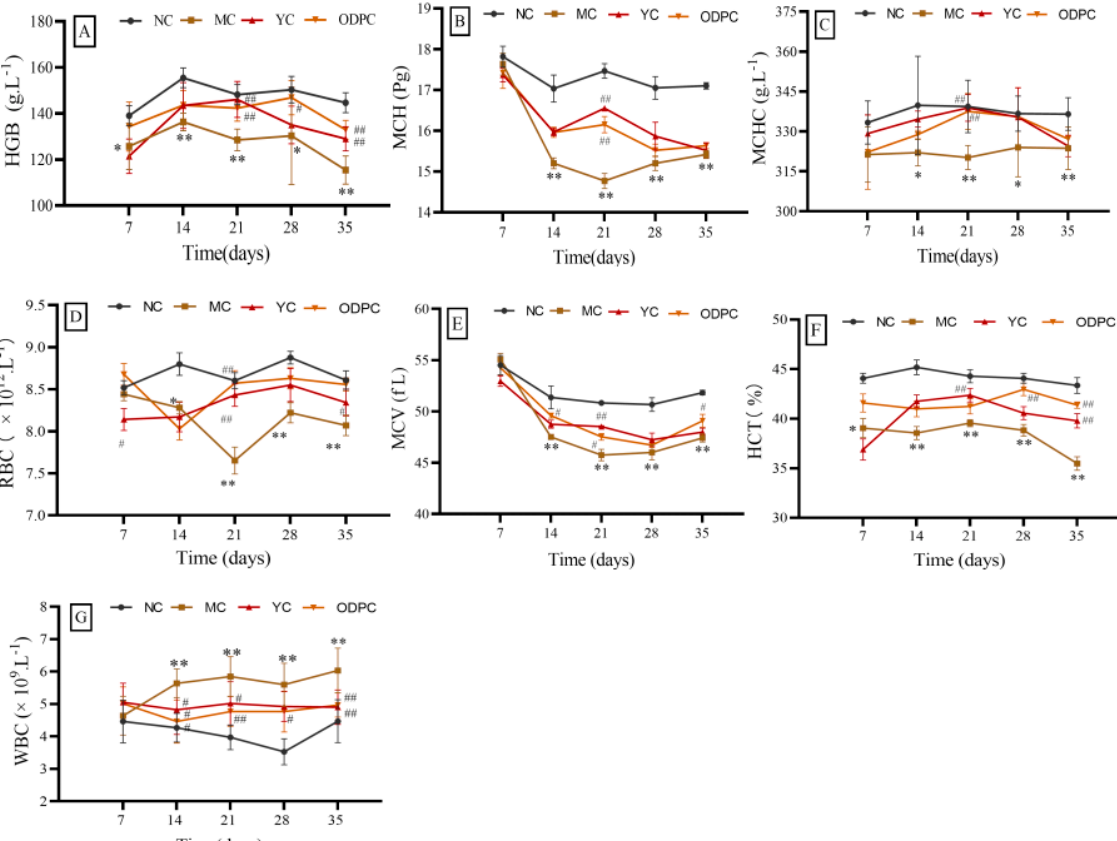
Figure 4. Time–effect relationship of ODP on peripheral blood indexes in mice: ( A – G ) are HGB, MCH, MCHC, RBCs, MCV, HCT, and WBCs, respectively. NC: normal control group, MC: CdCl 2 - treated group, YC: positive-treated group, ODPC: ODP-treated group. * Compared with normal control group (NC group), # compared with model control group (MC group). * p < 0.05, ** p < 0.01; # p < 0.05, ## p <